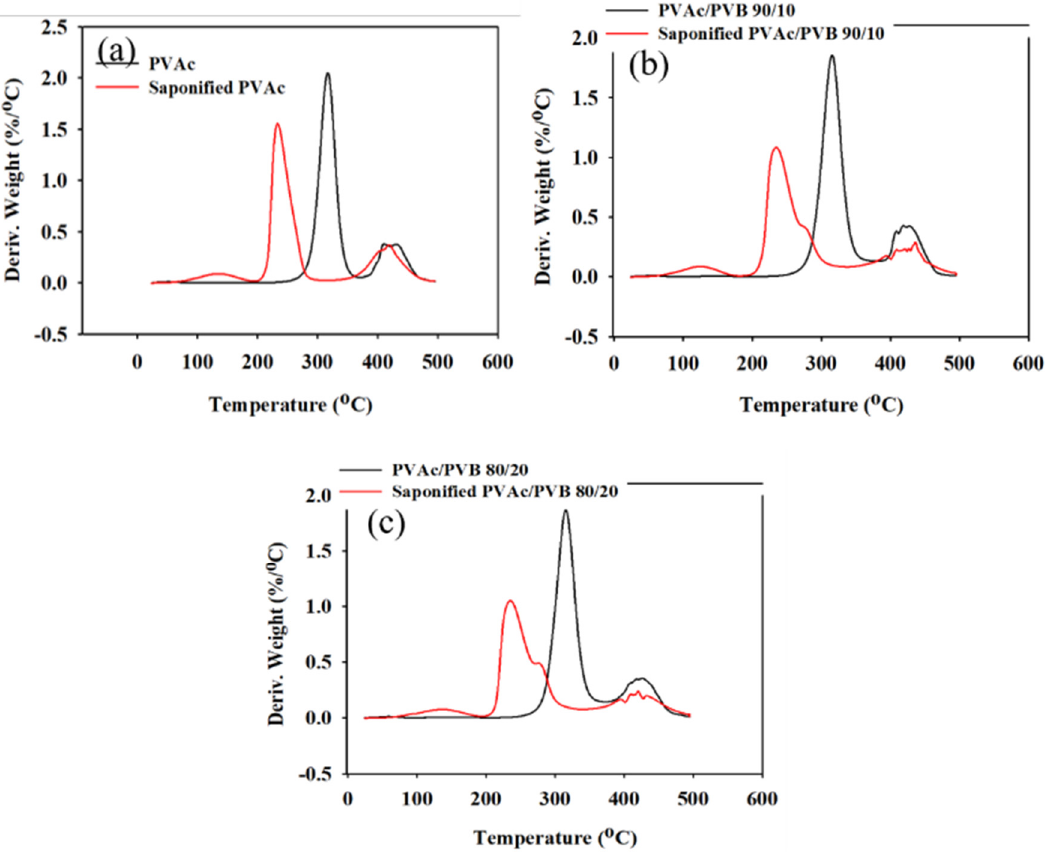
Figure 7. DTG data of unsaponified and saponified ( a ) PVAc film, ( b ) PVAc/PVB 90/10 blend film, and ( c ) PVAc/PVB 80/20 blend film (saponification temperature, 50 °C; saponification time, 72 h). Table 3. TGA and DTG data of saponified and unsaponified PVAc films measured at a heating rate of 10 °C min − 1 . WLR max , maximum weight loss rate.